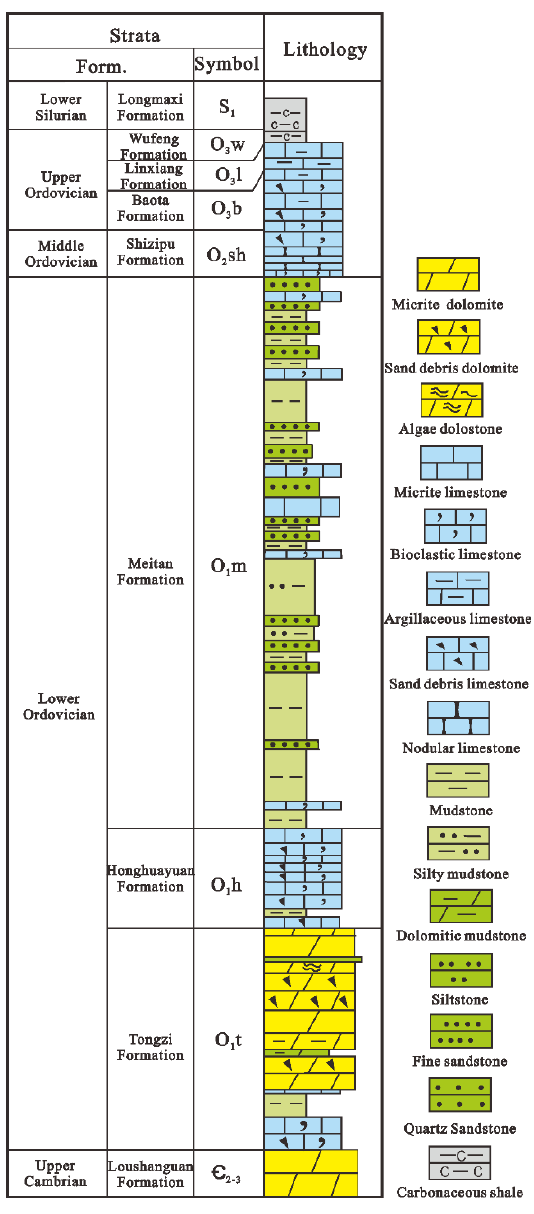
Figure 2. Stratigraphic column map of the Ordovician of the Sichuan Basin and its adjacent areas.